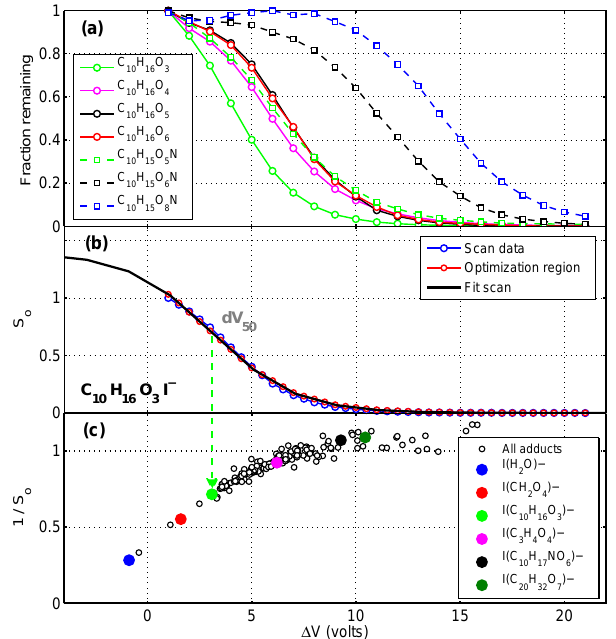
phase products measured from the reaction of α -pinene in the pres- ence of ozone and NO x . Some iodide adducts dissociate rapidly during the first few voltage steps. Multifunctional nitrates and highly oxidized C 10 molecules show no dependence on the initial voltage steps before dissociating. We infer these compounds to be strongly bound to I − , and therefore likely detected at a high sensi- tivity. Middle: an example of a non-linear least-squares fit to the declustering scan is shown for C 10 H 16 O 3 I − . The raw scan data are shown in blue circles, the region of optimization for the fit is shown in red, and the extrapolated scan curve is shown in black, constraining S o . Bottom: the results of fitting declustering scans (1 /S o ) shows a plateauing effect as a function of d V 50 . We use d V 50 as a measure of the relative binding energy between compounds. In colored dots, specific molecules are shown which span the binding enthalpy